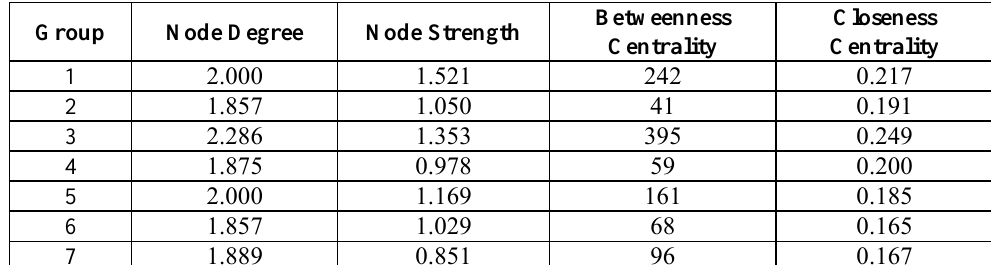
Table 3. Average central indexes of groups